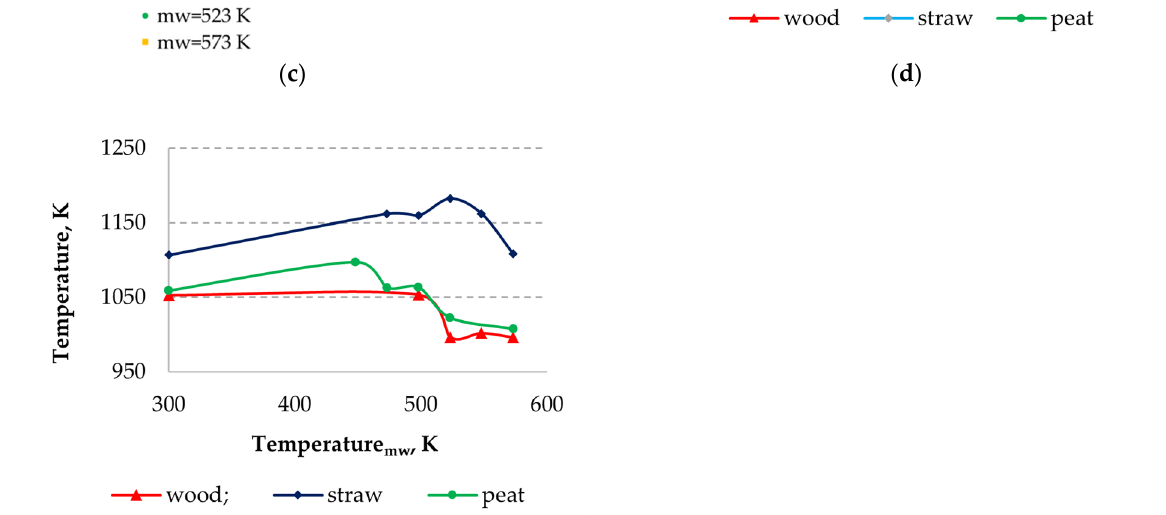
Figure 8. The effect of variations of the mw pretreatment temperature on the kinetics of the flame temperature during the burnout of wood ( a ), wheat straw ( b ) and peat pellets ( c ), on the relative duration of the burnout of pretreated pellets ( d ) and on the average values of the flame temperature ( e ).